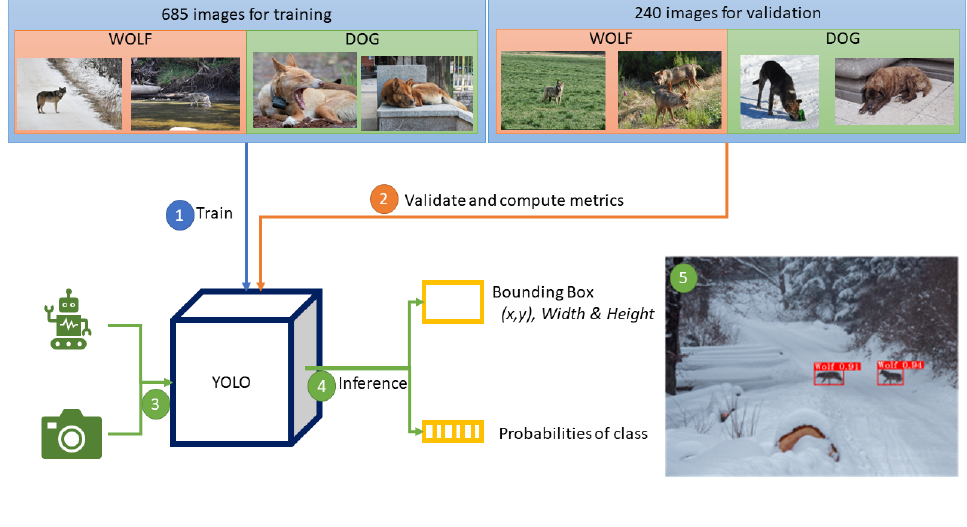
Figure 6. Complete scheme of the proposed vision module.